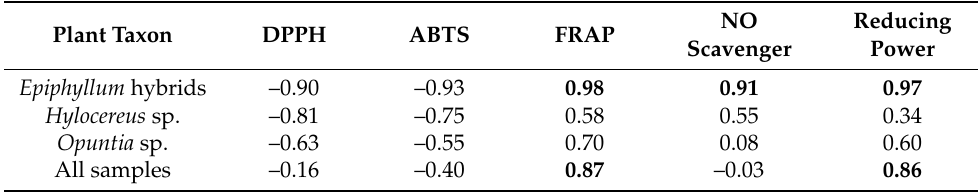
Table 6. Correlation coefficients between total betalain content and antioxidant activity of Epiphyllum , Hylocereus , and Opuntia